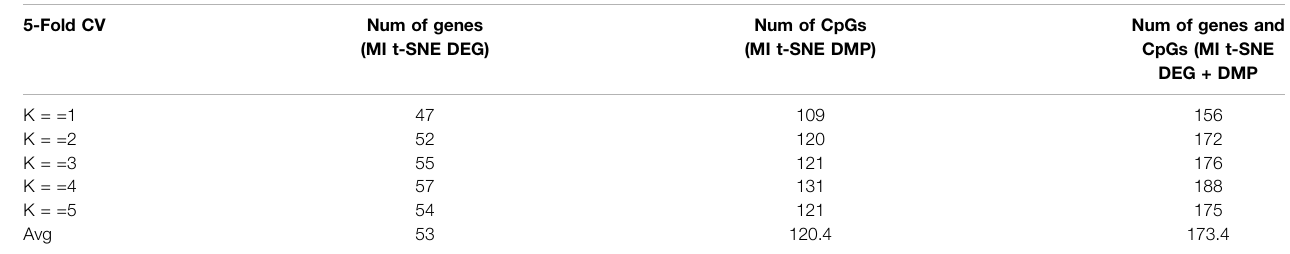
TABLE 3 | Dimensions of different feature extraction algorithms in each fold